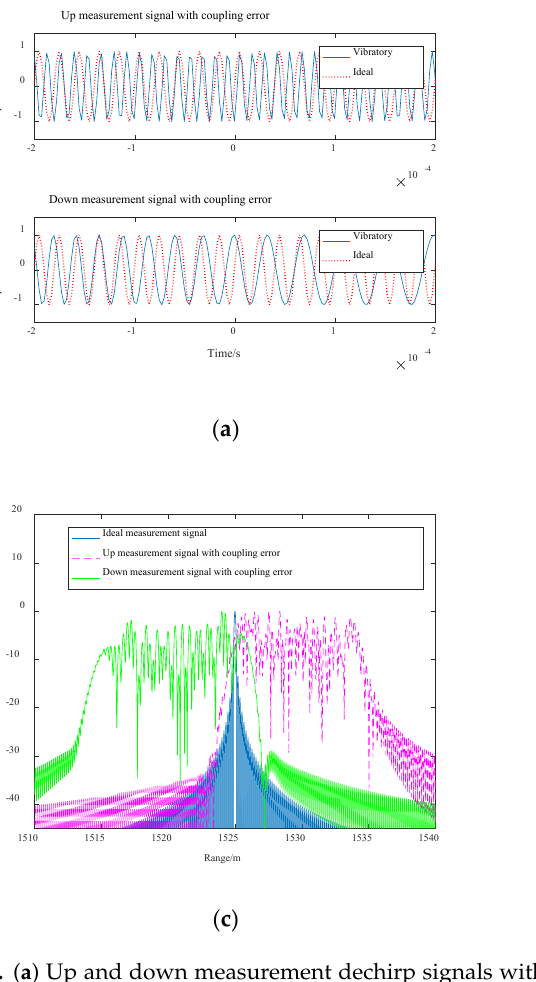
Figure 9. ( a ) Up and down measurement dechirp signals with coupling error; ( b ) Up and down measurement dechirp signals with coupling error and signal − to − noise ratio (SNR) of 5 dB; ( c ) One-dimensional range profiles of the measurement dechirp signals with coupling error; ( d ) One-dimensional range profiles of the measurement dechirp signals with coupling error and SNR of 5 dB.